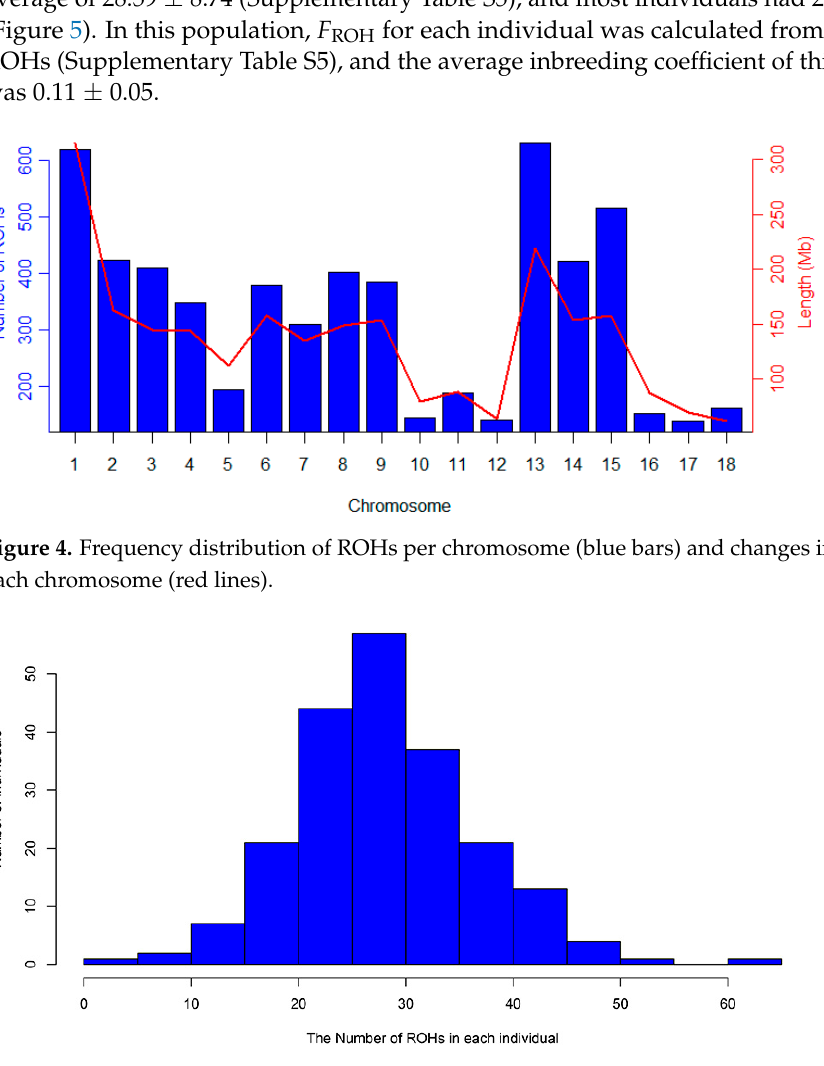
Figure 5. Frequency distribution of ROHs in each individual.